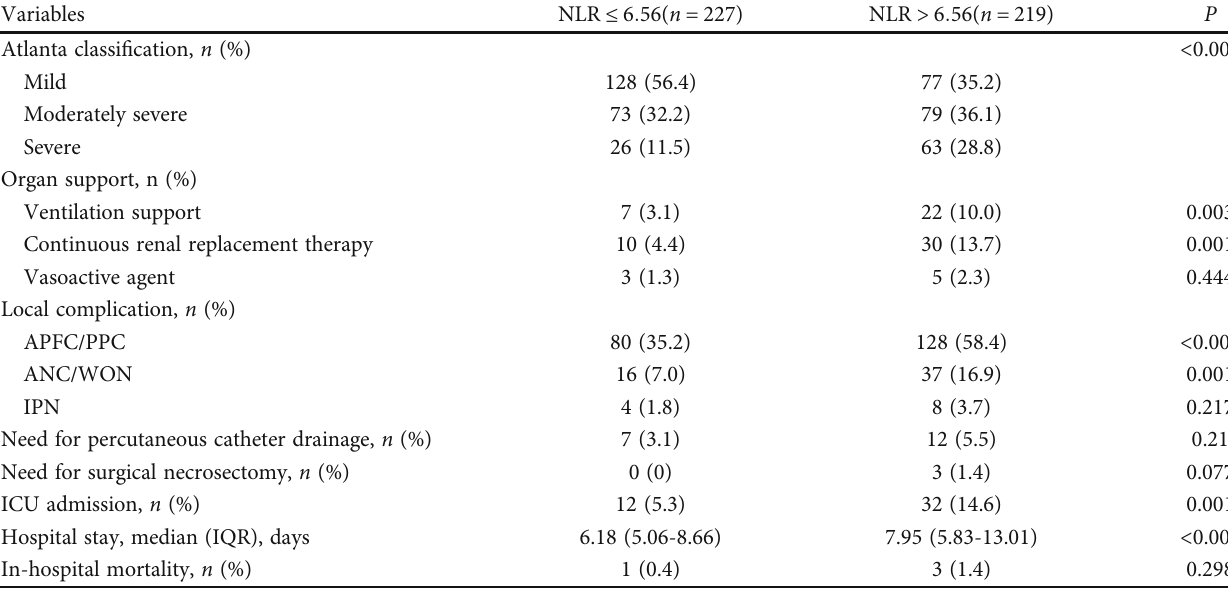
Table 3: Clinical course by NLR